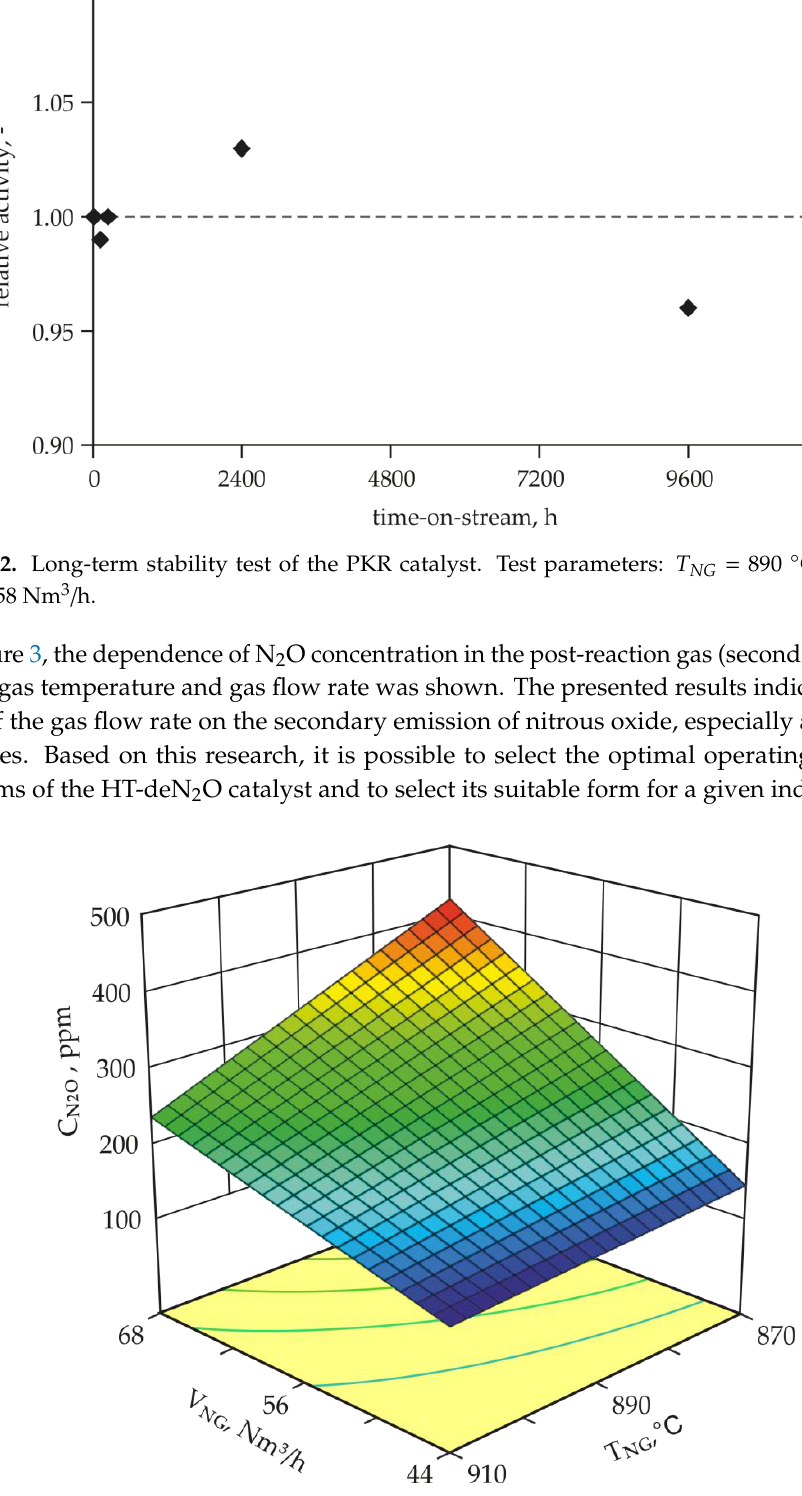
Figure 3. The dependence of N 2 O concentration in the nitrous gas downstream of the PKR catalyst layer on the nitrous gas temperature and nitrous gas flow rate.